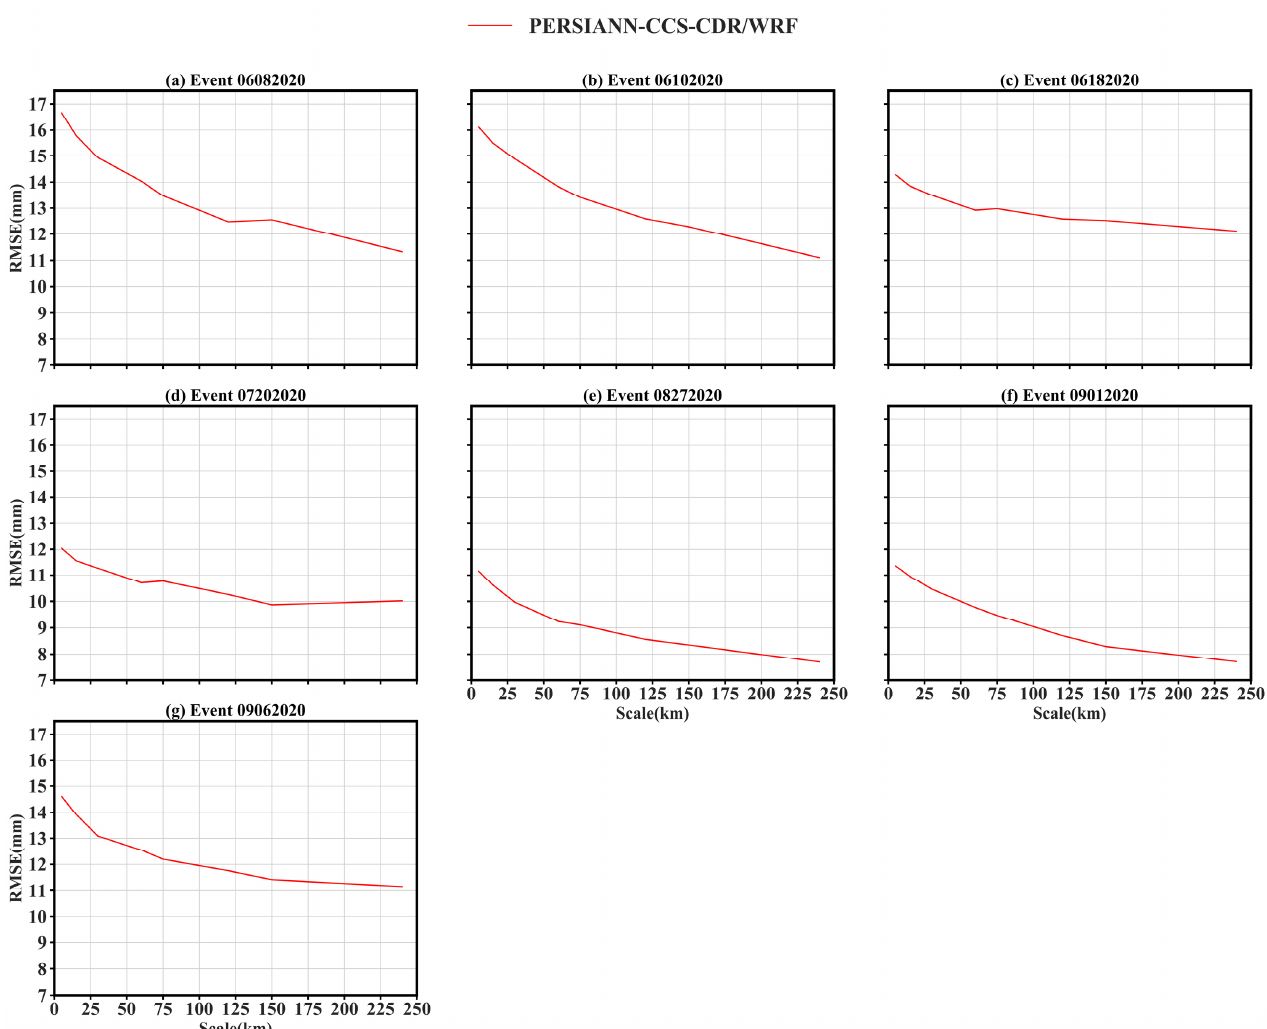
Figure 10. Spatial scale (km) against mean RMSE (mm) calculated from the mean precipitation obtained from the WRF and PERSIANN-CCS-CDR data